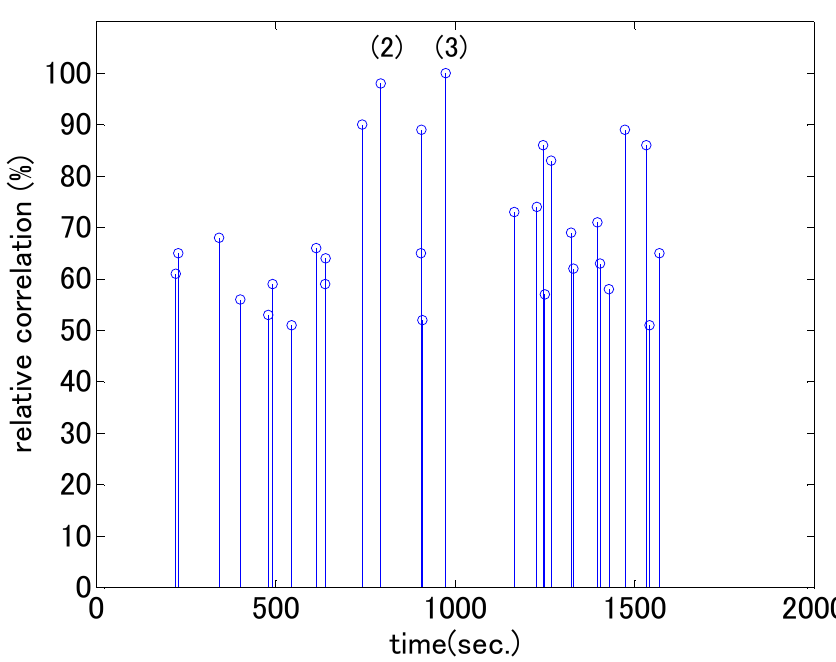
Figure 6. Cross-correlation values of head accelerations in the second dialogue (values greater than 50% of the maximum are shown). The horizontal axis corresponds to time frame t f in Equation (5). The numbers in parentheses correspond to the numbers in Table